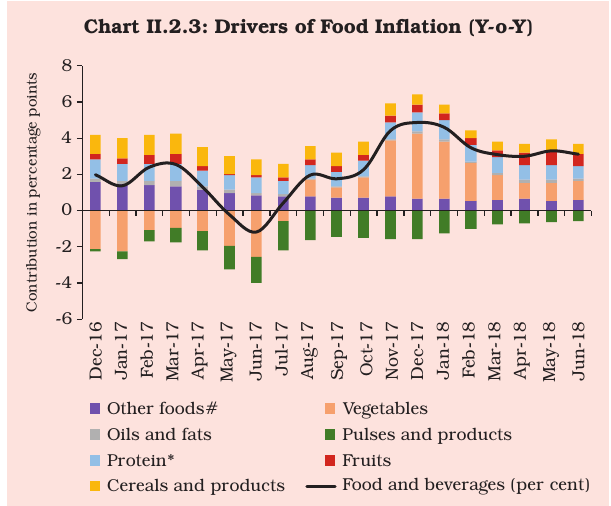
Source: CSO and RBI staff